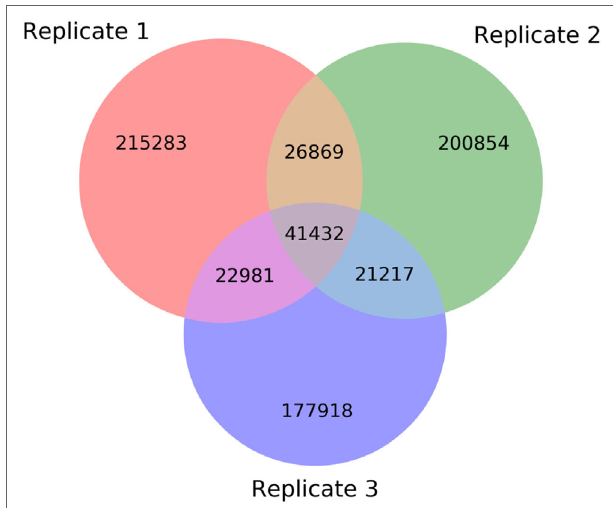
FIguRe 11 | Venn diagram showing the number of variable region amino acid sequences that are shared among next-generation sequencing